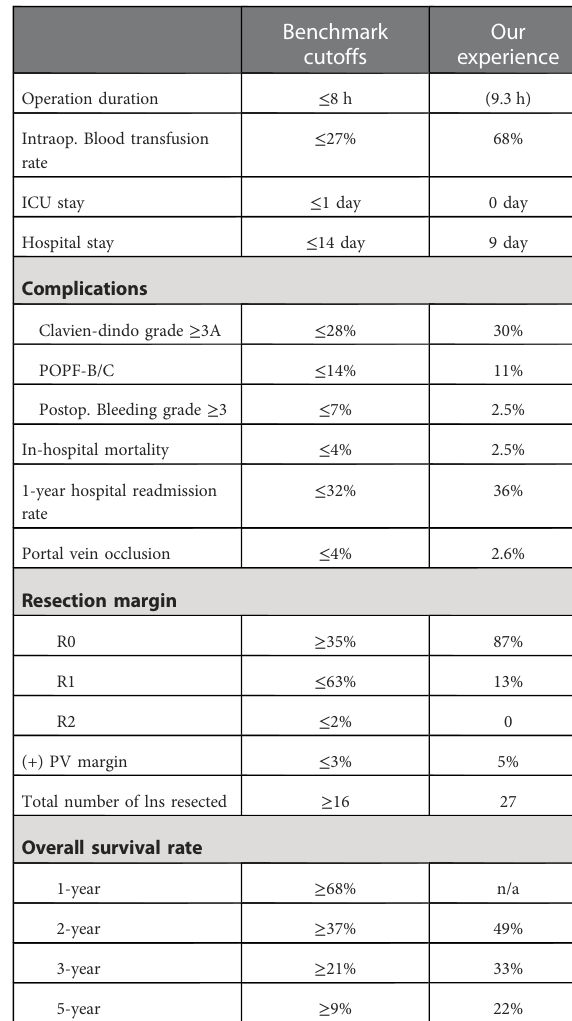
TABLE 2 Comparison of our results with the benchmark outcome for pancreatoduodenectomy and PV/SMV resection. (Our “ Operation duration ” includes the total time of patients ’ presence in the OR; not “ skin-to-skin ” time, n/a: not